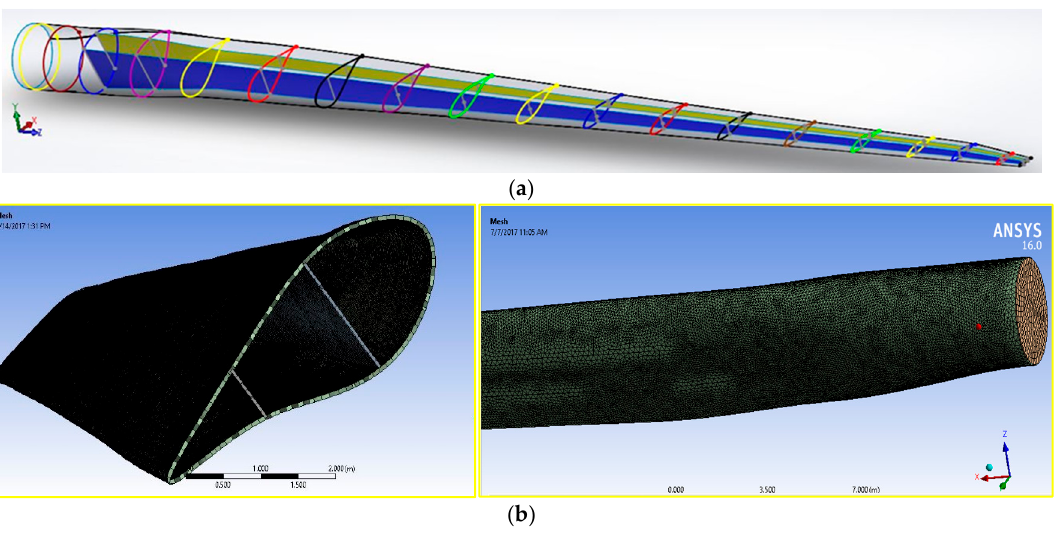
Figure 5. Aerofoil distribution along the blade span ( a ) and mesh ( b ) for the structural domain.